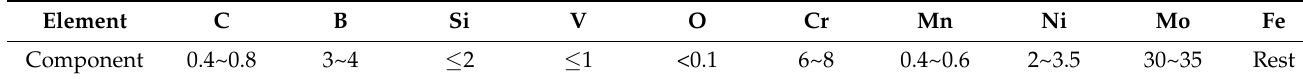
Table 3. Elemental composition (wt.%) of the Mo 2 FeB 2 powder.